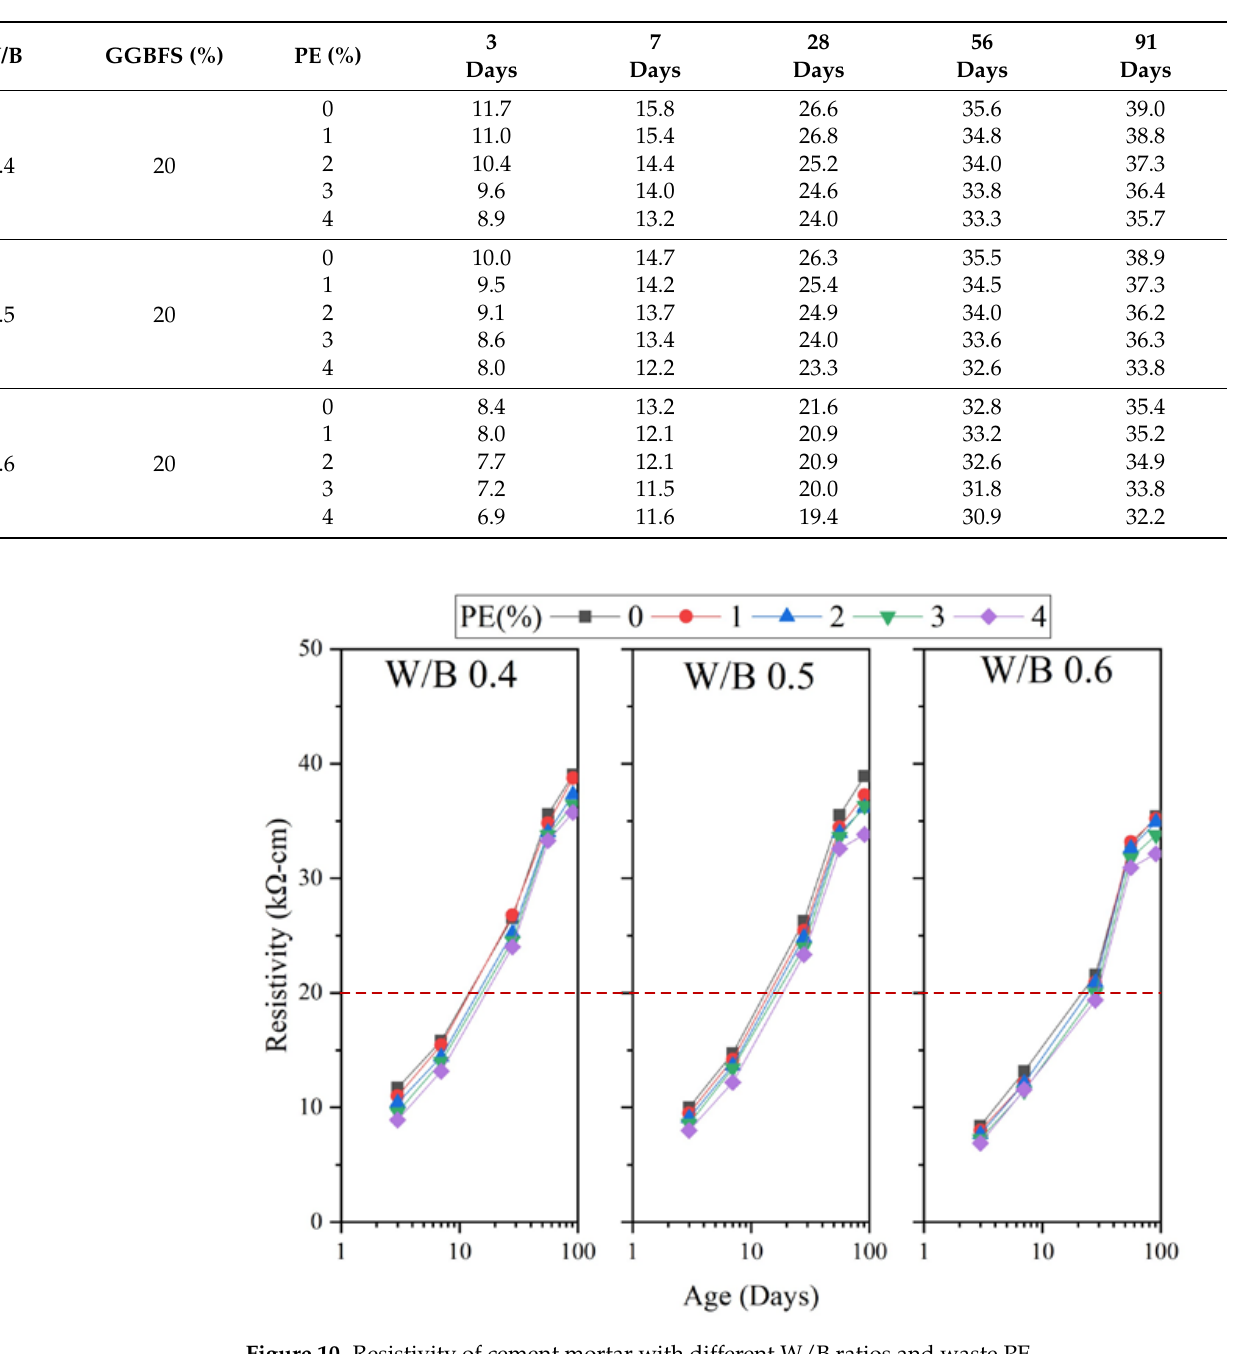
Table 8. Resistivity of cement mortar with different W/B ratios and waste PE (unit: k Ω -cm).